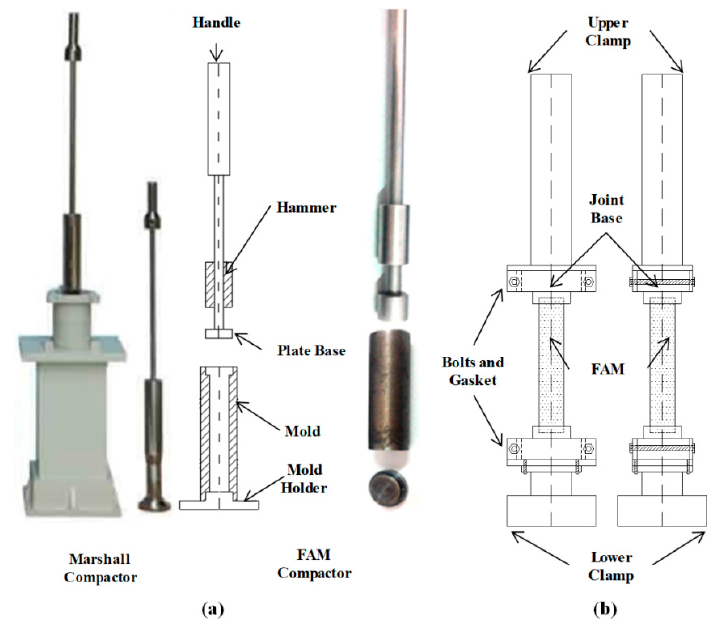
Figure 4. Compactors and DHR clamps: ( a ) Marshall compactor and FAM compactor, and ( b ) FAM cylinder, metal base, and rectangle clamps.